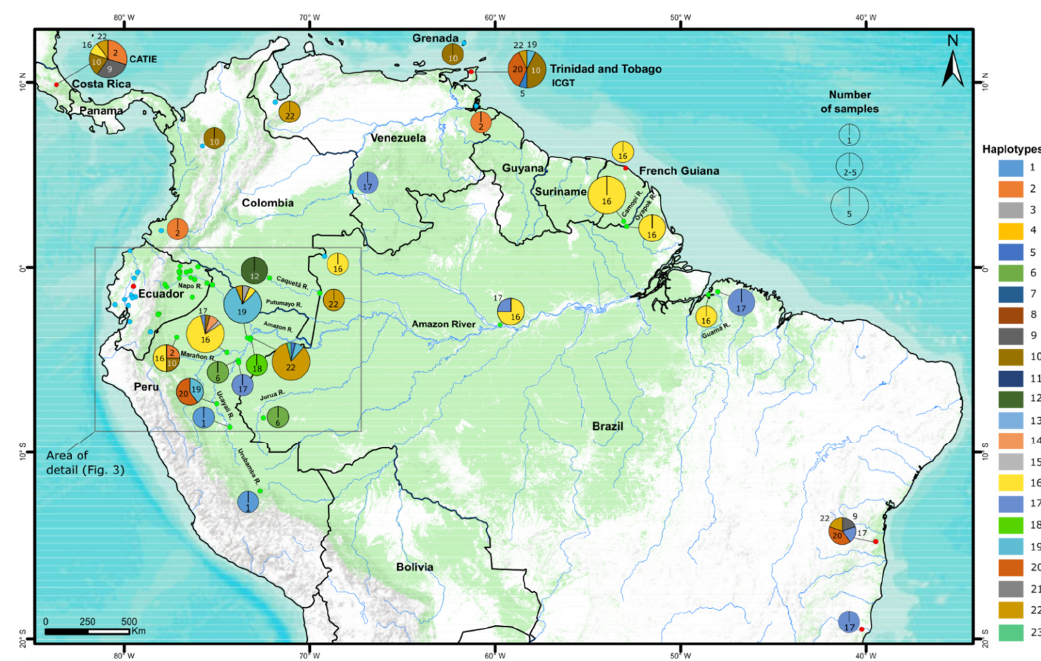
Figure 2. Distribution and frequencies of chloroplast haplotypes among Theobroma cacao L. populations in the Amazon basin. The rectangle represents the area of high haplotype diversity in northwestern Amazon (displayed in detail in Figure 3). The green dots represent samples from natural populations, the blue dots plantations, and the red dots accessions in breeding stations (CATIE-Tropical Agricultural Research and Higher Education Center, ICGT-International Cocoa Genebank Trinidad). The size of the circles is proportional to the number of samples per location. In contrast, only two haplotypes (H16 and H17) were found in central and eastern Amazonia (Figure 2). Both the total ( H T = 0.087) and the within population ( H S = 0.037) haplotypic diversity were low in eastern Amazonia (Table 2). When compared, eastern and western cacao populations were highly divergent ( F ST = 0.500), since they shared only two haplotypes in this study (Figure 2).